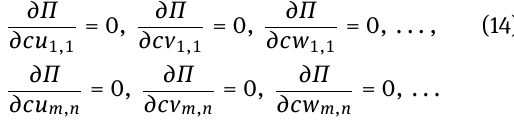
Using Eqs. (10), (12) and (13), the potential energy of the shell is obtained as a function of the unknown coeffi- cients. Now, the unknown coefficients are determined by the minimum potential energy principle. The unknown co- efficients should be obtained such that the potential en- ergy becomes minimum.